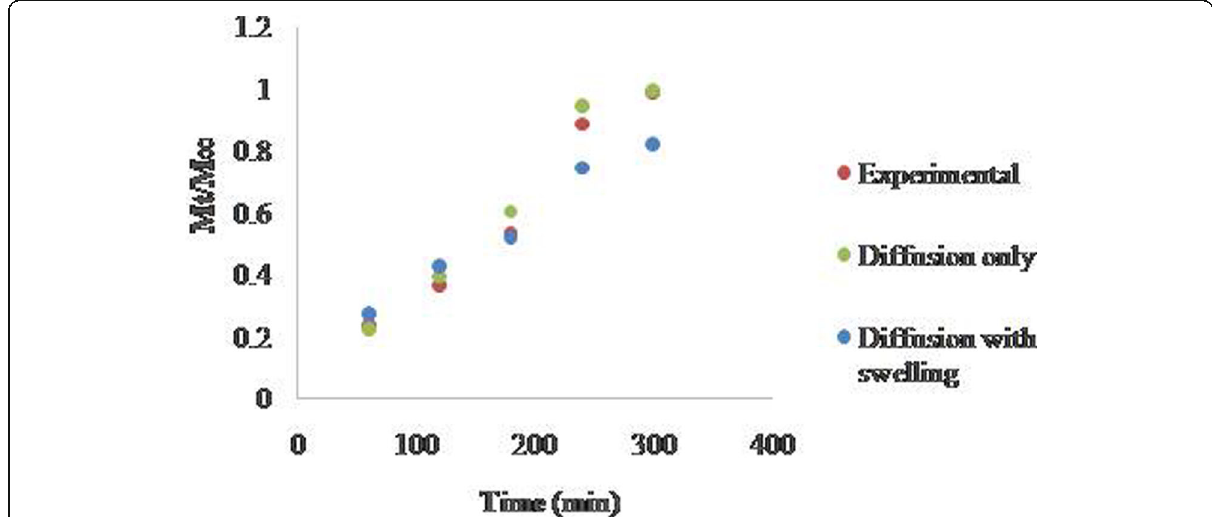
Fig. 4. The validity of the model: predicted with diffusion only, diffusion with swelling, and experimentally determined relative amount of THP release from Ca-ALG NP versus time [release medium: phosphate buffer (pH